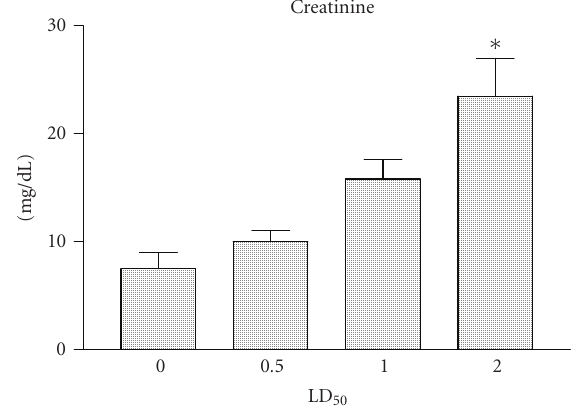
Figure 4: Creatinine determination . Groups of female mice from the BALB/c strain, 13–15 g of body weight, were injected i.p. with 0.5, or, 1 and/or 2 LD 50 of Cdt. After 2 hours the mice were bled and the creatinine levels present in sera were determined. Each vertical bar represents the mean plus or minus the standard deviation value of samples from the results obtained with two experiments carried out with two independent groups of five mice each. Statistical di ff erences between the injections were marked with asterisk ( P < .